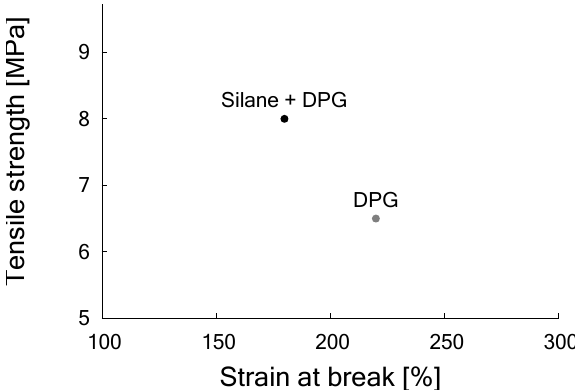
Figure 9. Tensile stress vs. strain at break of samples of DGTR after revulcanization with DPG only, Formulation 3 in Table 3; and with DPG and TESPT, Formulation 4 in Table 3.